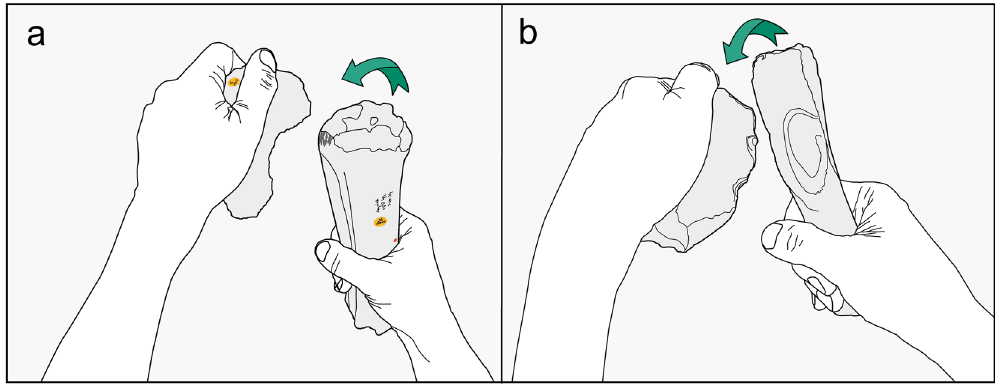
Figure 12. Reconstruction of Clactonian flintknapping using bone hammers to modify flakes struck from a core with a hard hammer. ( a ) bison metatarsal NHMUK PV M 15260, ( b ) deer tibia NHMUK PA E